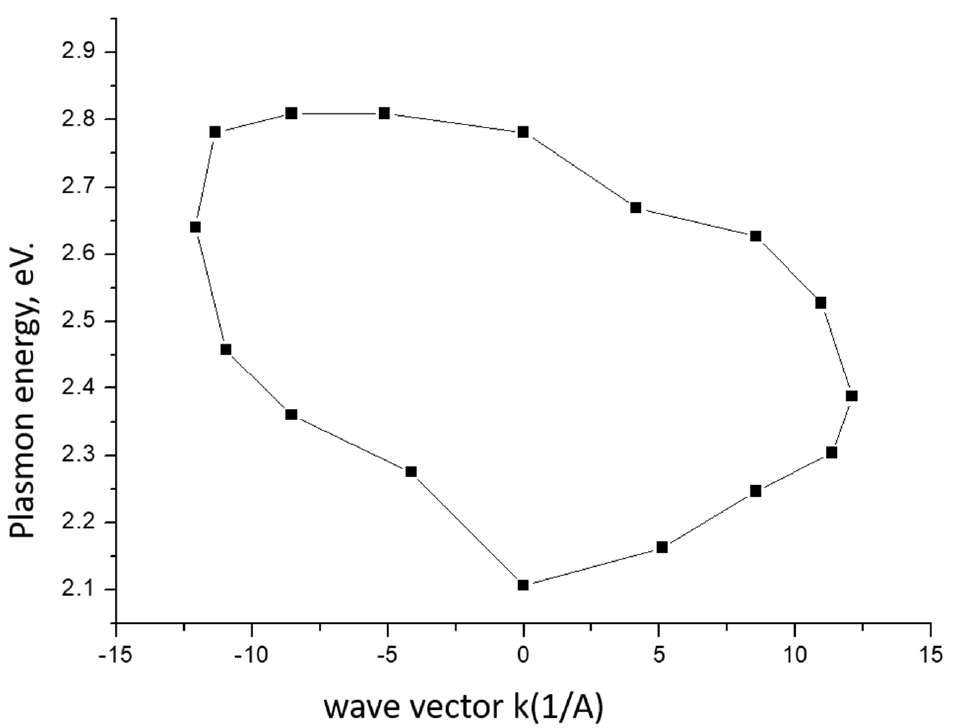
Figure 13. Dispersion of plasmons in a thin film of vanadium dioxide № 1 on a sitall. Table 7. Experimental data, plasmon energies and other microscopic characteristics of a thin film of vanadium dioxide № 1.